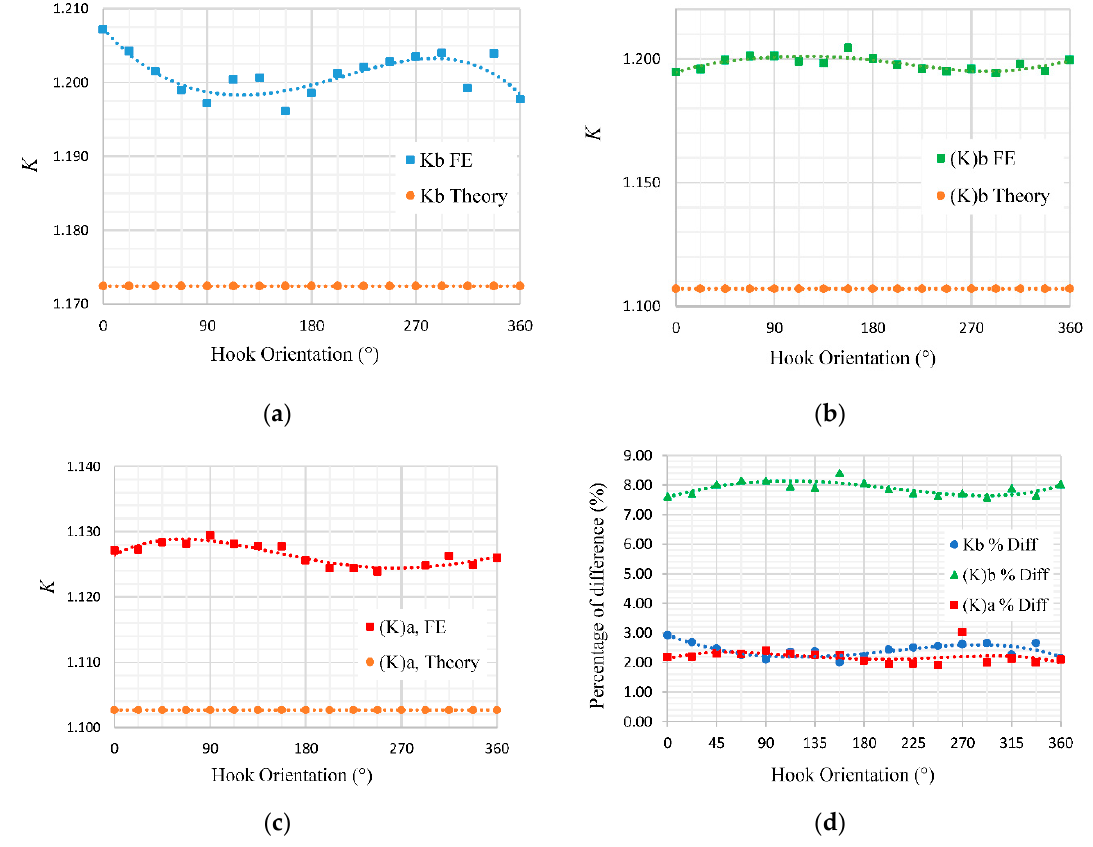
Figure 9. Effect of hook orientation on K FE measured at ( a ) the spring body, ( b ) point B and ( c ) point A; ( d ) the percentage of difference between the correction factors obtained through the FE methods and the theoretical approach.